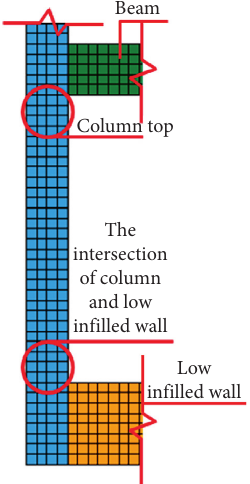
Figure 50: Initial state of first-floor middle column.